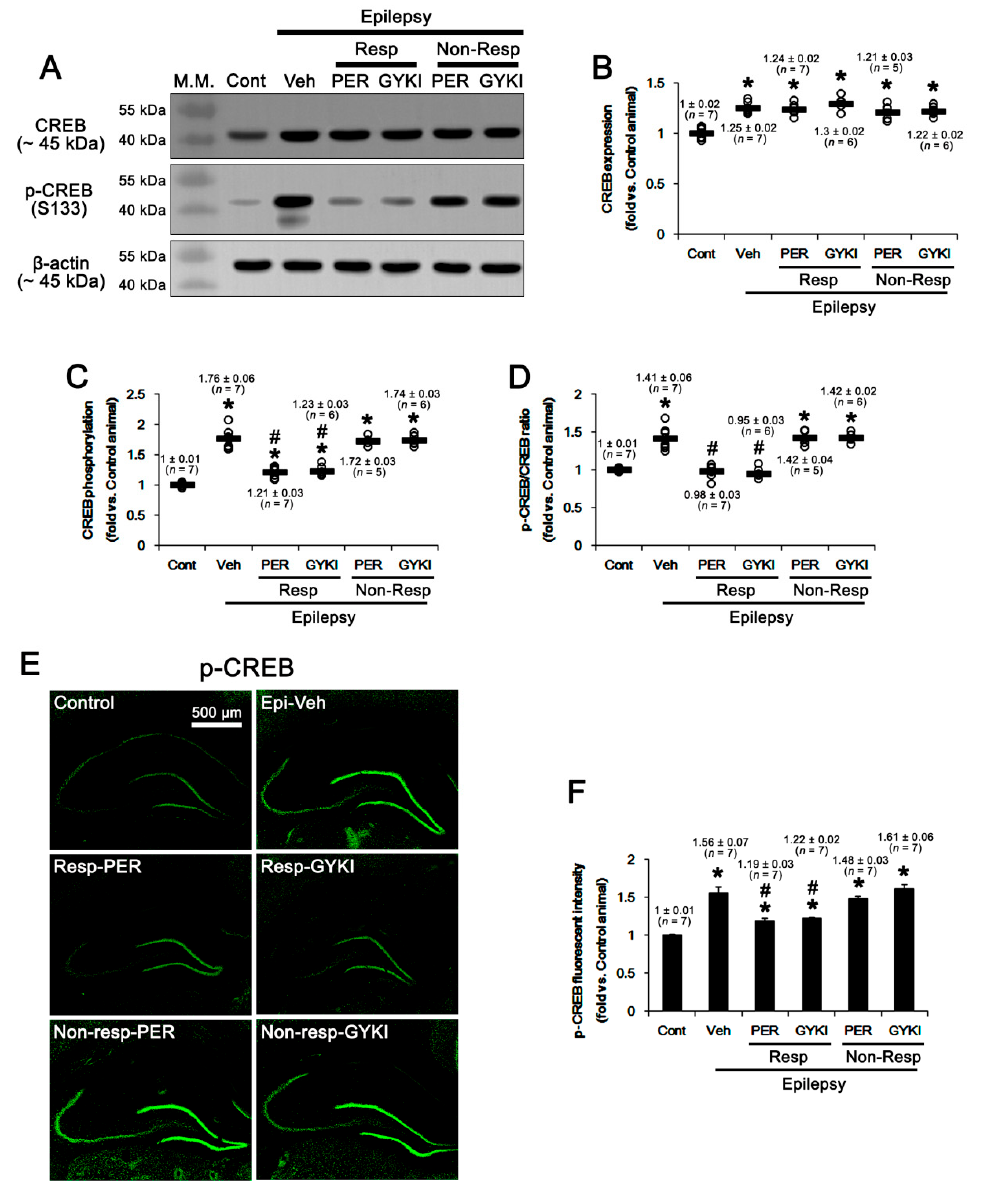
Figure 6. The e ff ects of perampanel (PER) and GYKI 52,466 (GYKI) on total Ca 2 + / cAMP response element-binding protein (CREB) and its S133 phosphorylation in chronic epilepsy rats. Both AMPAR antagonists reduce CREB S133 phosphorylation in responders (Resp), but not non-responders (Non-Resp). ( A ) Representative images for Western blot of CREB and p-CREB levels in the hippocampal tissues. ( B – F ) Quantifications of CREB ( B ), p-CREB S133 ( C ), and p-CREB S133 ratio ( D ) levels in the hippocampal tissues. Open circles indicate each individual value. Horizontal bars indicate mean value. Error bars indicate SEM ( * , # p < 0.05 vs. control and vehicle (Veh)-treated animals, respectively; one-way ANOVA with post hoc Bonferroni’s multiple comparison).